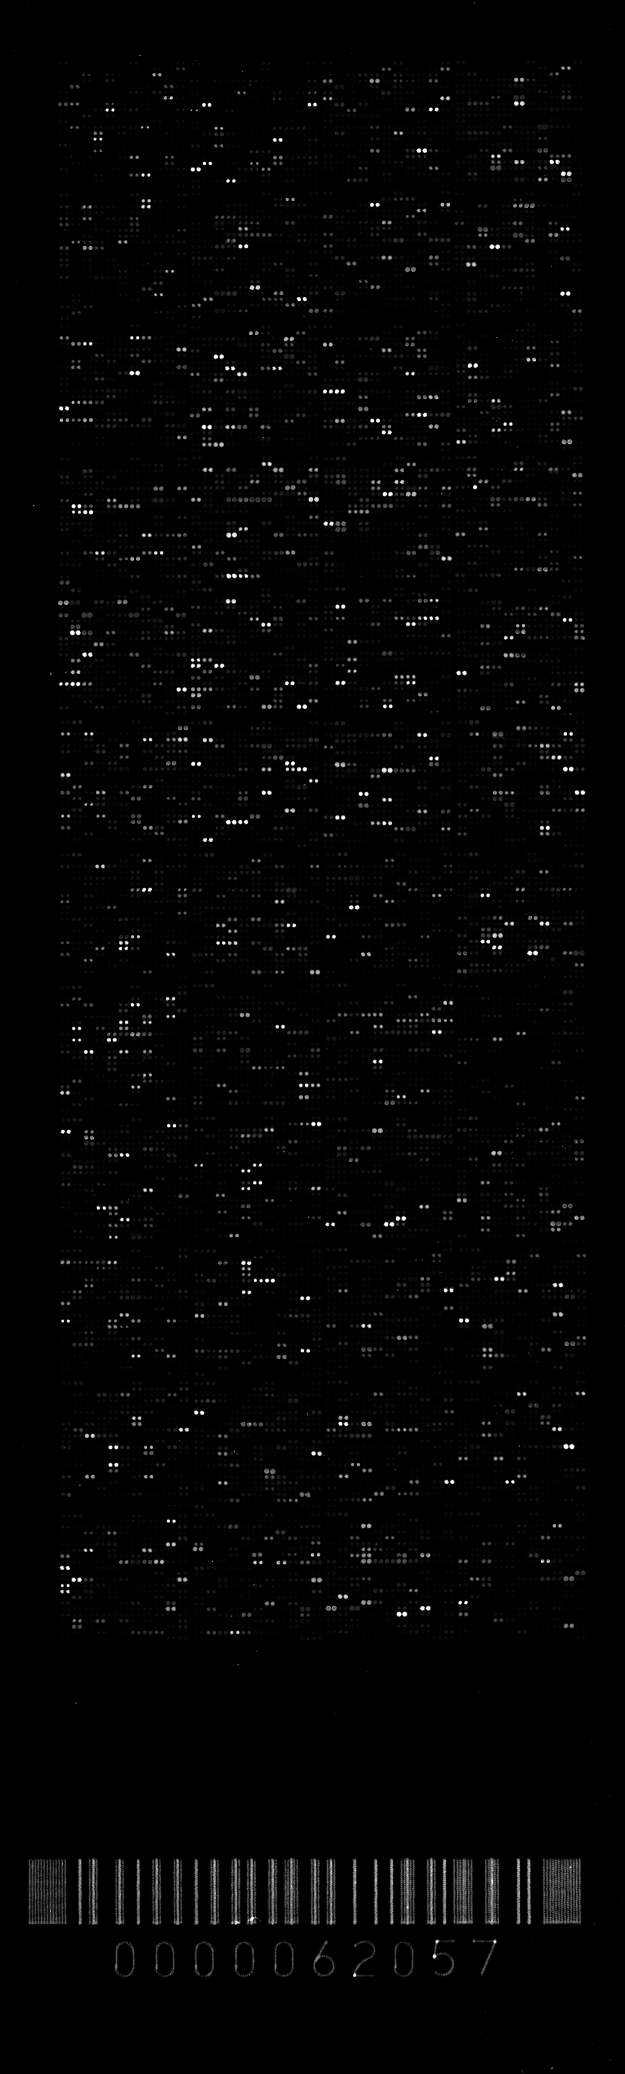
High Resolution Array Image. Experimental assay with G4-2, profiled at 2.5 μM.